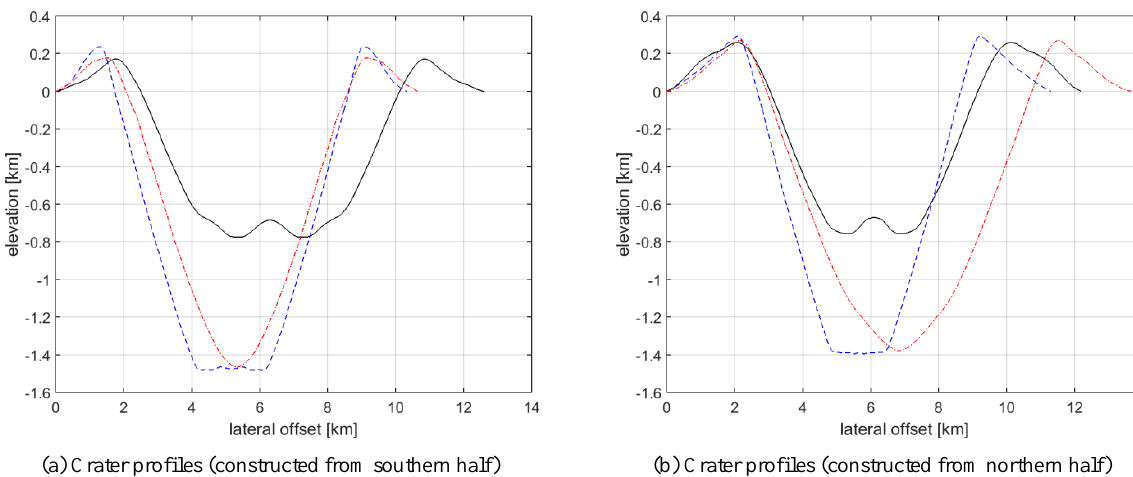
Figure 1. Cross-sections of the crater models. The crater models were constructed from LOLA tracks that closely resemble cross- sections of approximately 8 km diameter satellite craters of the lunar crater Plato. Each track was split at the centre of the cross- section, respectively, and the models were derived by rotating the resulting profiles around the centre of the corresponding satellite crater, respectively. (a) Model cross-sections derived from the southern half of the LOLA track. (b) Model cross-sections derived from the northern half of the LOLA track. Trained on Tested on